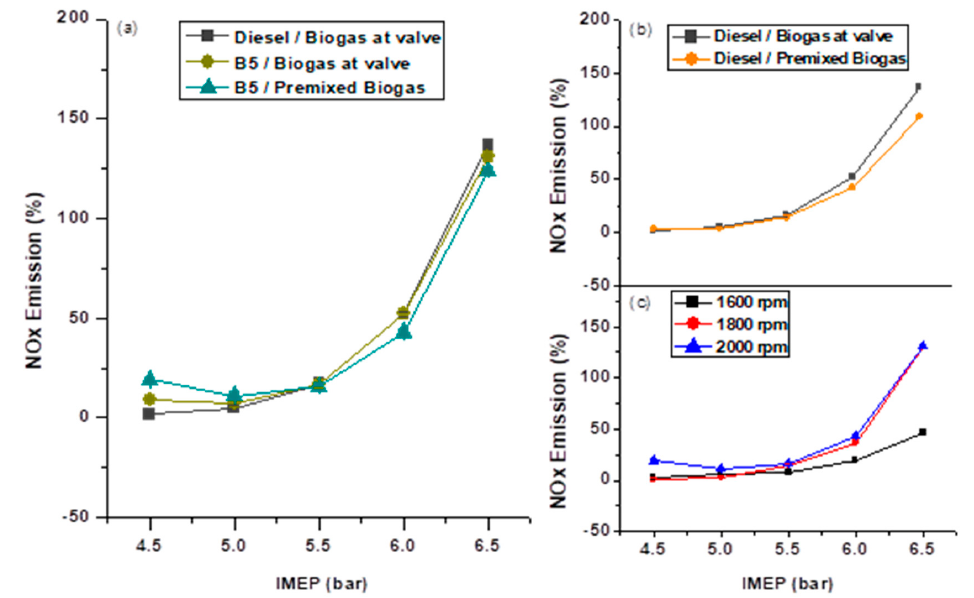
Figure 18. Engine-out NOx emission for ( a ) B5/biogas RCCI for premixed and port injection at the valve, ( b ) diesel/biogas in a premixed and port injection at the valve, and ( c ) B5 and premixed biogas RCCI combustion at various engine speed.